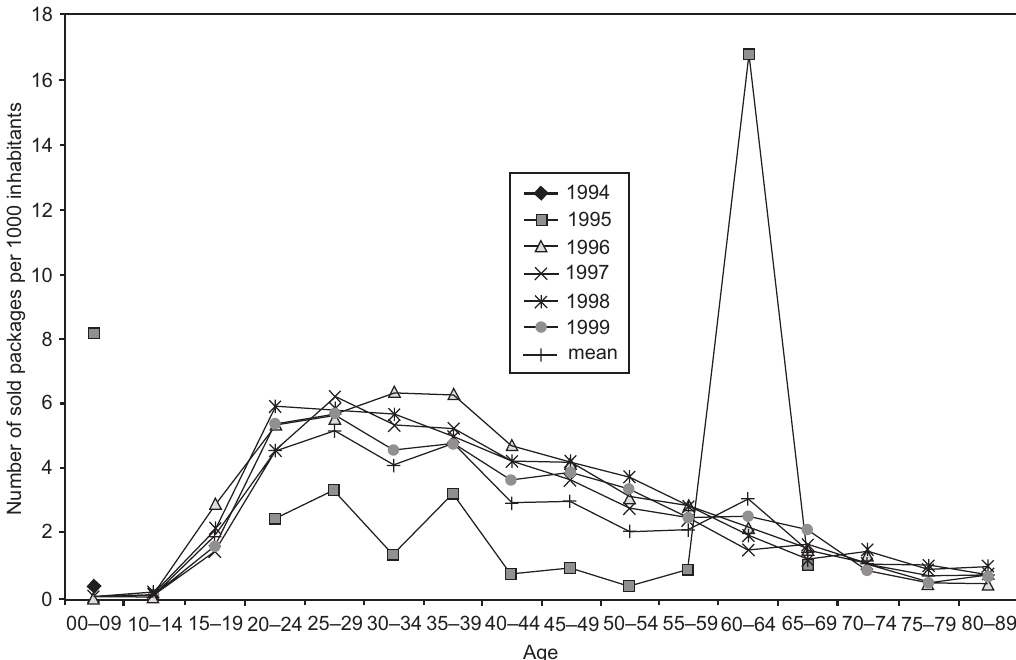
Figure 4 Number of prescriptions of four capsules of 100 mg itraconazole (Sporanox 1 ) sold per age group in Ska ˚ ne county, Sweden, during the